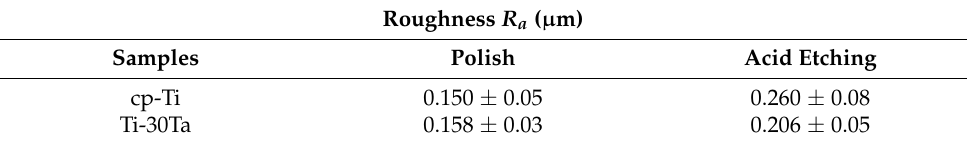
Table 4. Non-coated cp-Ti and Ti-30Ta surface